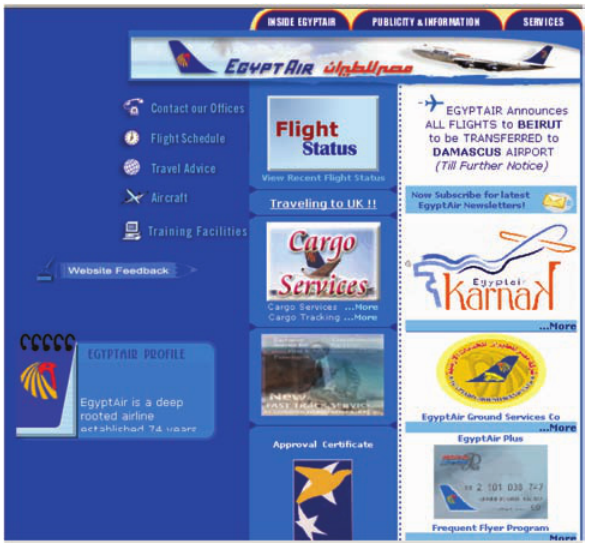
Fig 6. Reasons for choosing an